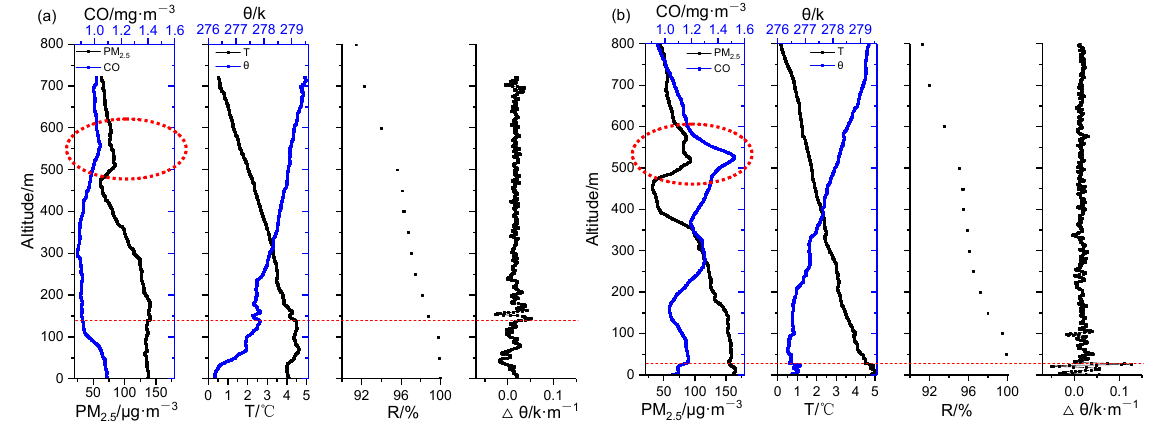
Figure 5. Profiles of the PM 2.5 concentration, CO concentration, T, R, θ and ∆ θ with height at ( a ) 20:00 LST and ( b ) 23:00 LST on 4 January 2019. The R profile was detected by microwave radiometers, and the other element profiles were obtained by the UAV. The red dashed line represents the boundary layer height, and the red circle denotes the peak value of high-concentration atmospheric pollutants in the upper layers.